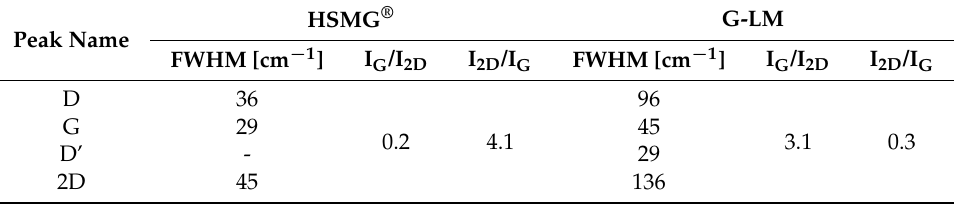
Table 2. FWHM (full width at half maximum) values and ratios of typical peaks calculated on the basis of Raman spectra